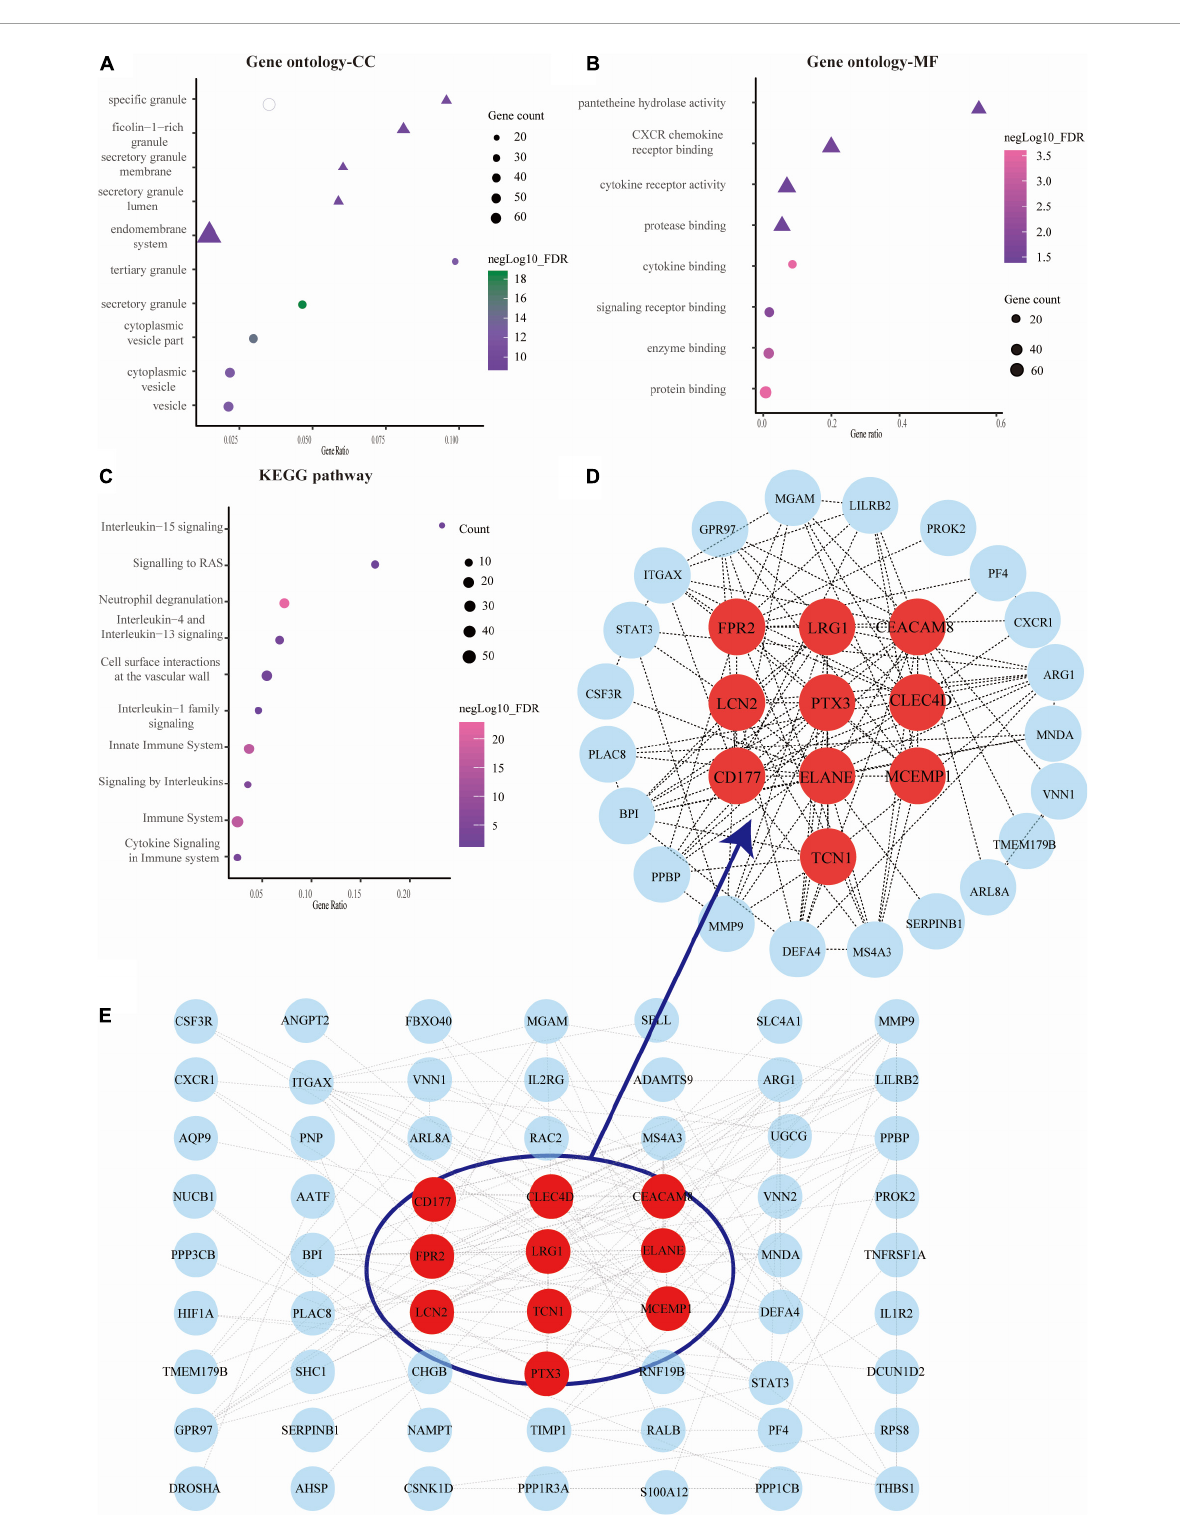
FIGURE3 Analysis of gene ontology (GO) function, Kyoto Encyclopedia of Genes and Genomes (KEGG) pathways, and protein-protein interaction (PPI) network of genes in septic cardiomyopathy (SC)-related modules. (A–C) The bubble map showing the GO function (cellular component, CC, and molecular function, MF) and KEGG pathways were constructed by the STRING database. The sizes represent negative Log10 (FDR). (D) The gene PPI network was also constructed based on the STRING database. (E) The plots showing the top 10 higher degree hub genes for